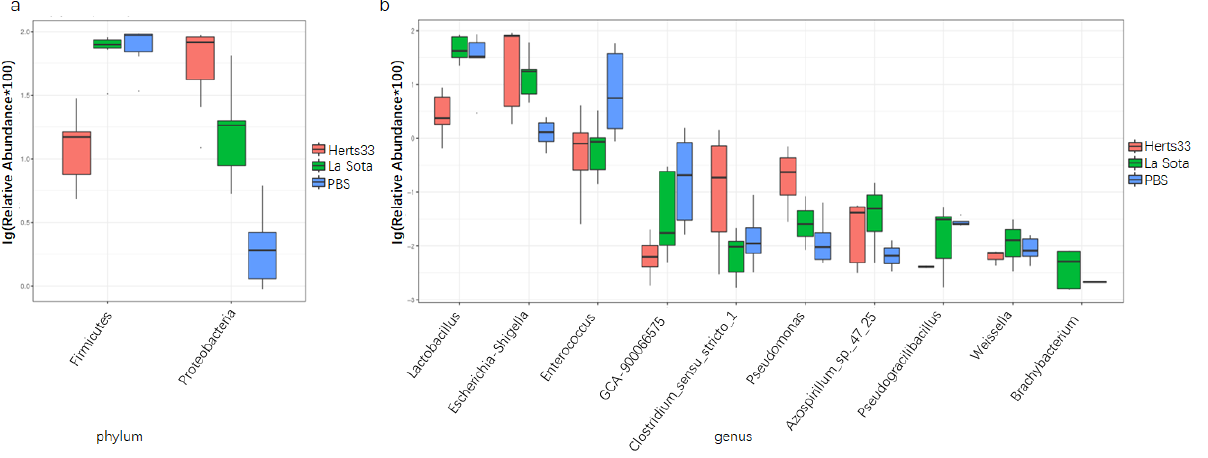
Figure 5. The relative abundance of the top 10 different bacteria in the three groups (ANOVA), expressed as an average percentage of the total: ( a ) At phylum level; ( b ) At genus level.